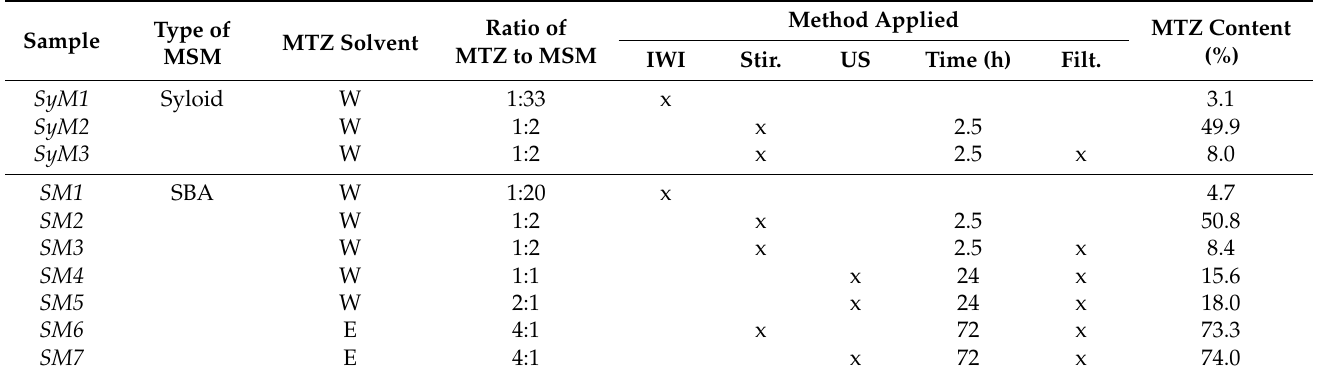
Table 1. Parameters for the preparation of metronidazole immobilized on two types of MSM. Type Sample